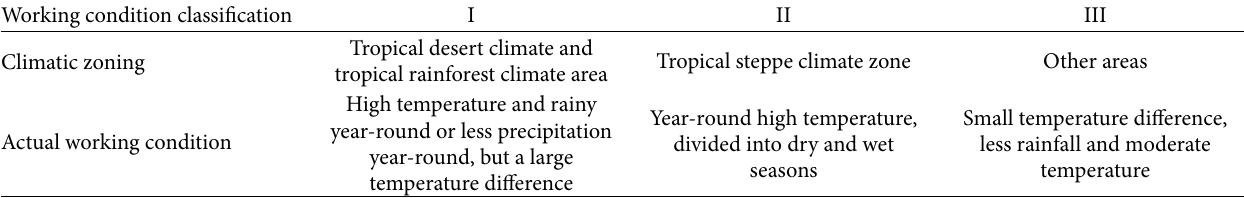
Table 8: Comprehensive climate zoning of airport overlay in hot and humid area.